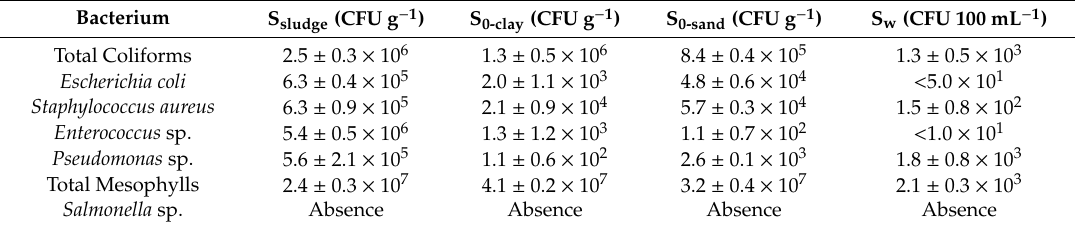
Table 4. Initial microbiological properties of treated sewage sludge, soils and irrigation water. Bacterium